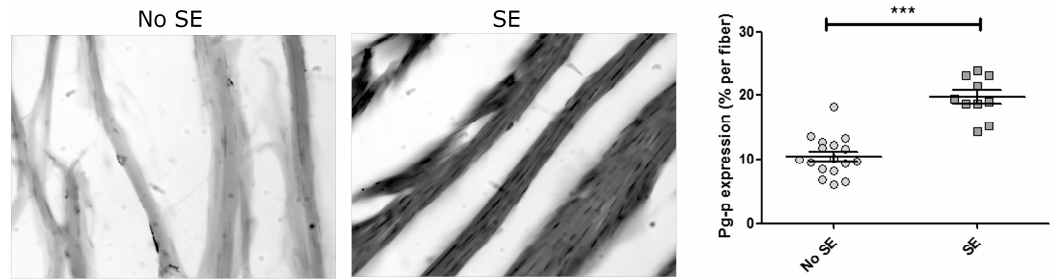
Figure 4. P-gp expression in myocardiocytes. Representative picture (20×) of the myocardiac fiber with or without SE and their respective quantitation. Values are given as mean ± SEM. Differences were analyzed by Student t -test with significance level of p < 0.001 (***).